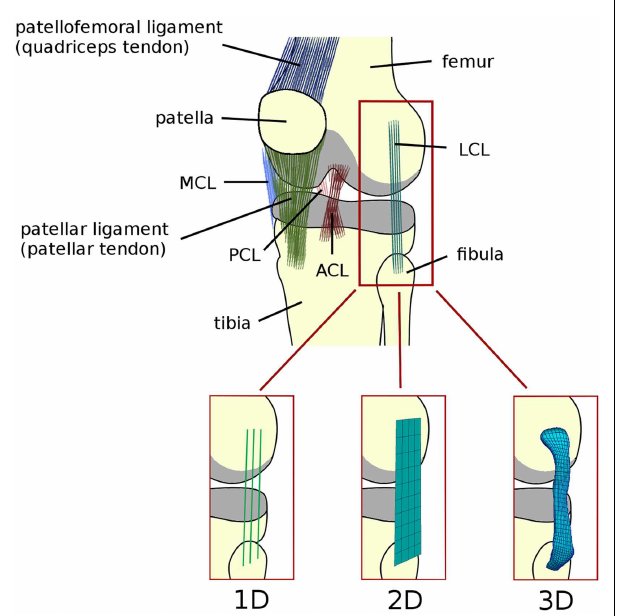
FIGURE 1 | Schematic representation of the anatomy of the knee joint, depicting the ligaments (ACL, anterior cruciate ligament; PCL, posterior cruciate ligament; MCL, medial collateral ligament; LCL, lateral collateral ligament) . Articular cartilage is shown in gray. Alternative names commonly used for the patellofemoral and patellar ligaments are reported in brackets. Schematic representations of 1D (springs, trusses, and beams), 2D (shell and membrane), and 3D elements (solid) used to model the knee ligaments are shown.